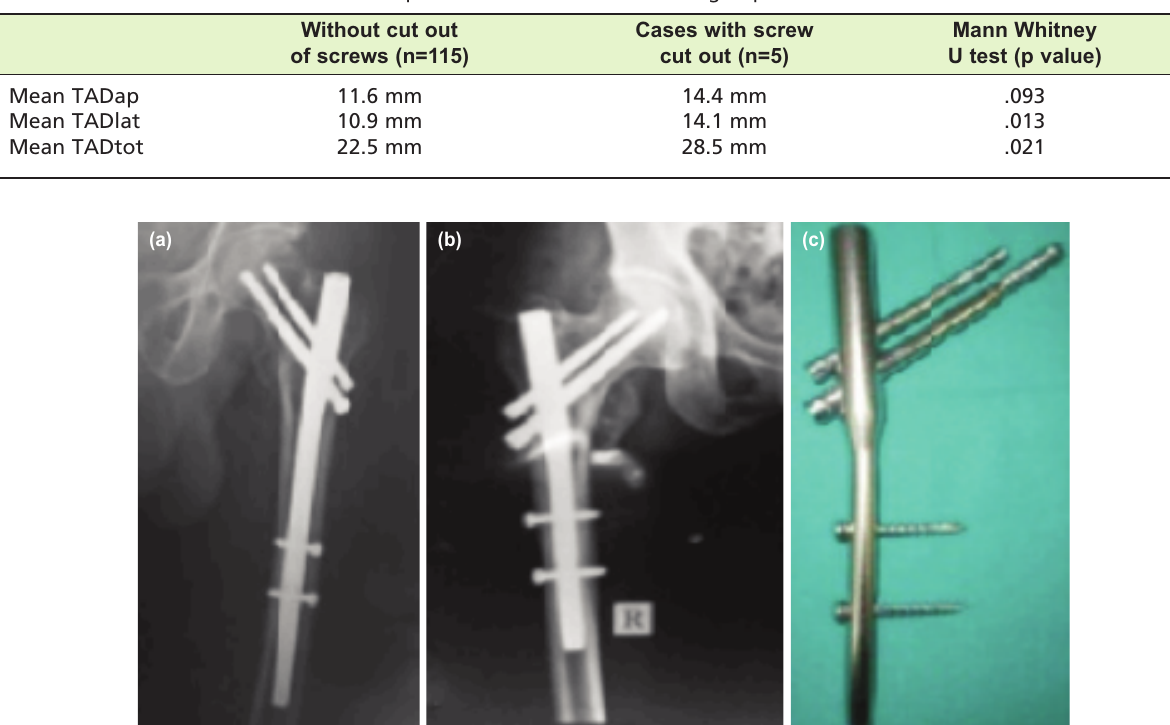
(a) radiograph of standard PFN, (b) radiograph of modified short PFN, (c) modified short PFN : compare how the standard PFN Fig. 1: (250mm-on the left) crosses isthmus while modified short PFN stays well short of